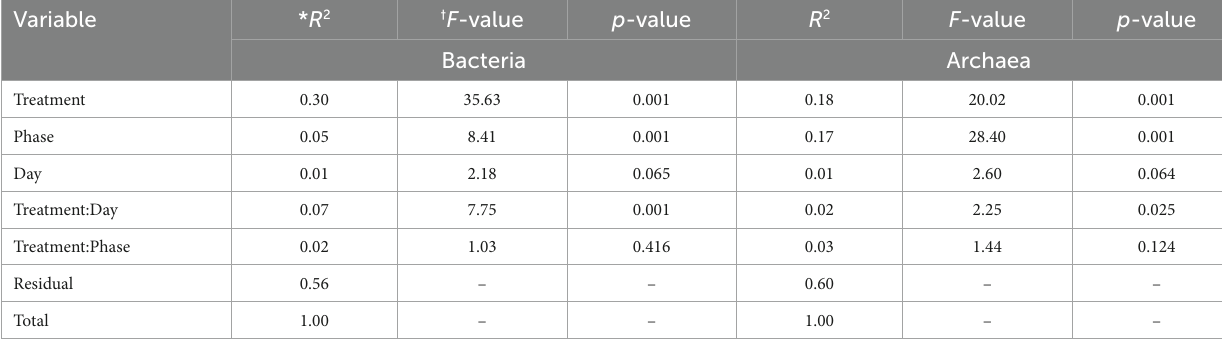
TABLE 1 Results of PERMANOVA analysis on bacterial and archaeal community dissimilarities.